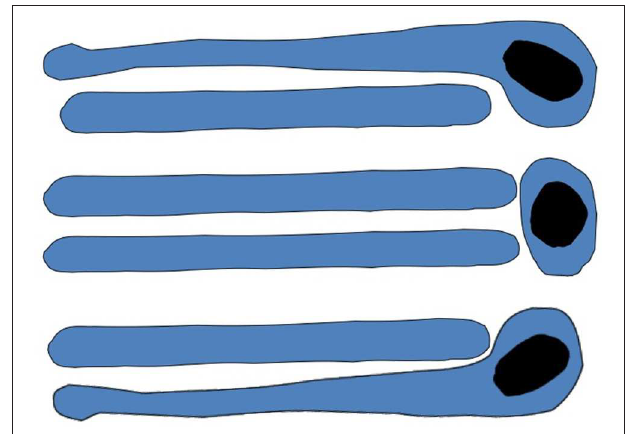
FIGURE 6 | Scheme of megavesicle-based intra-Golgi transport. This hypothesis assumes that completely isolated megavesicle (in the middle of both images) can be found near the Golgi